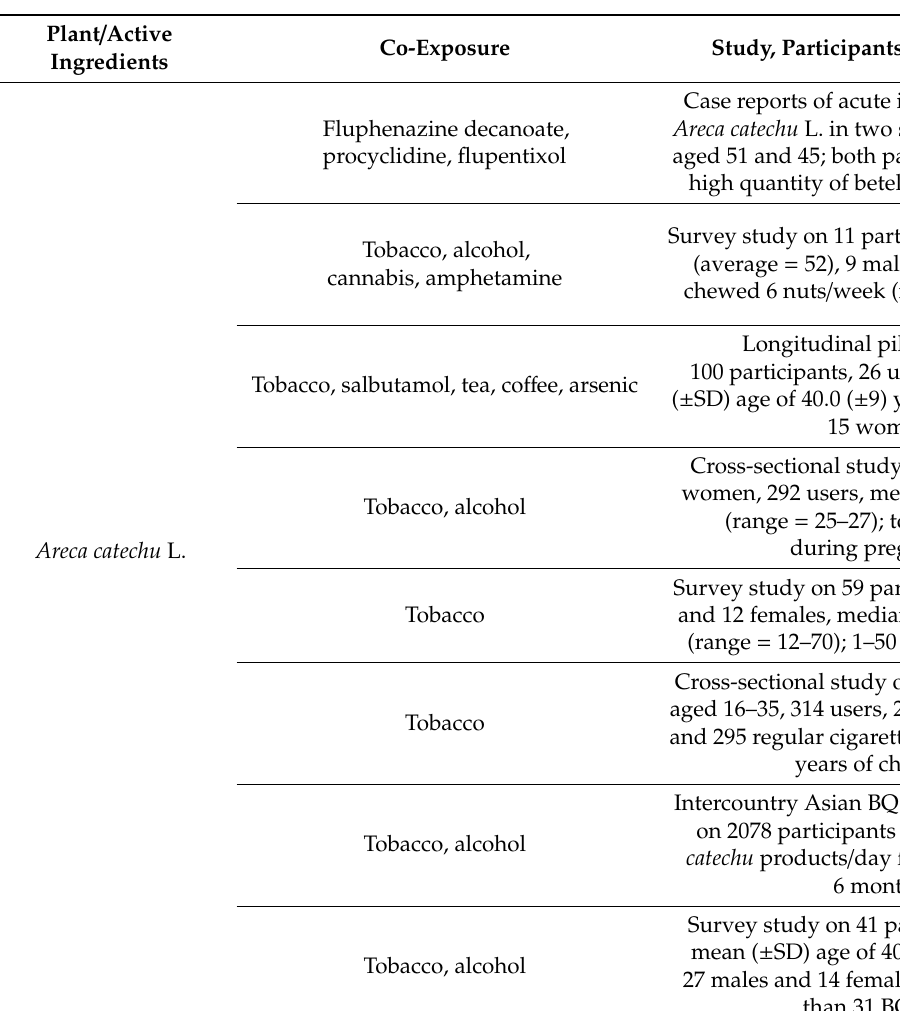
Table 1. Reports of psychiatric and neurological adverse events associated with herbal